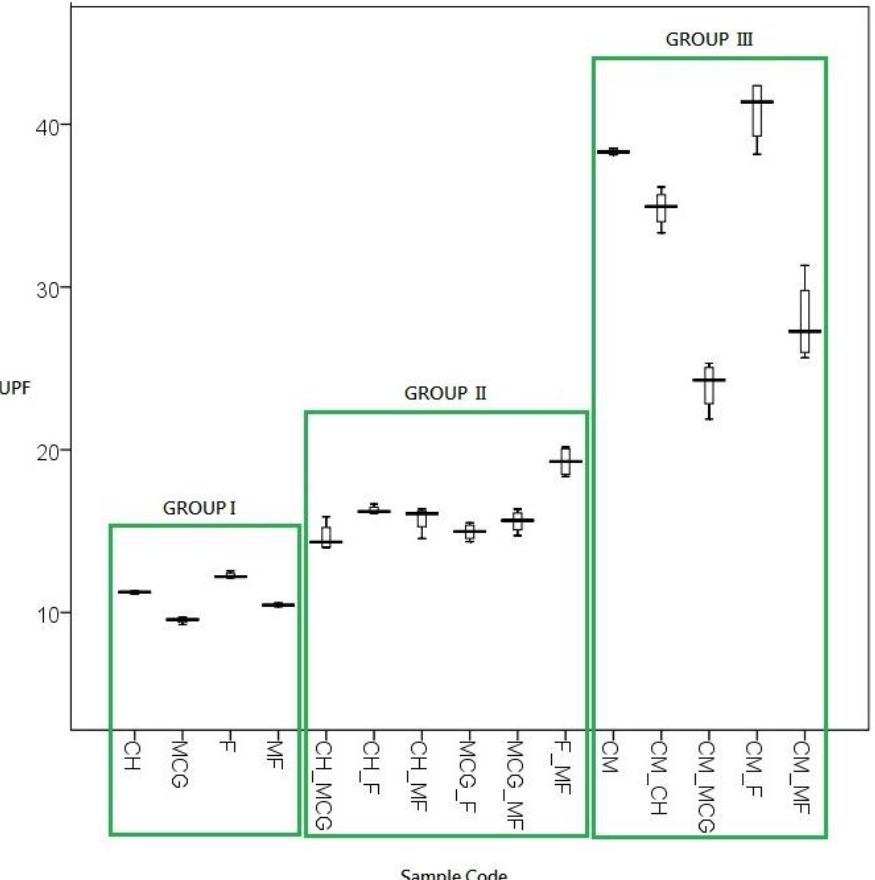
Figure 2. Box-and-whisker plot of UPF results of fabric samples in the three groups at dry and relaxed